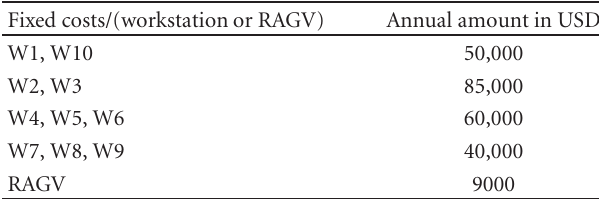
Table 4: Fixed costs.